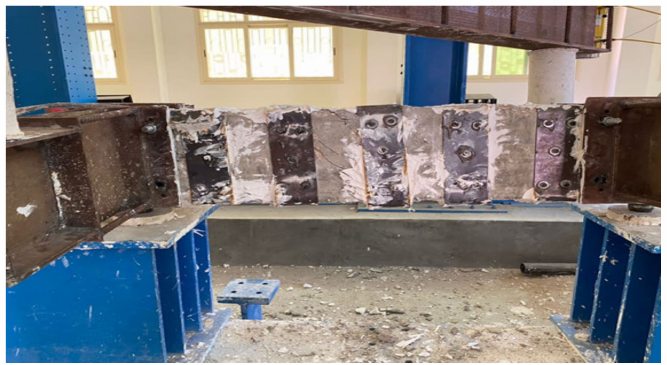
Figure 16. Final crack of beam B1-AS.